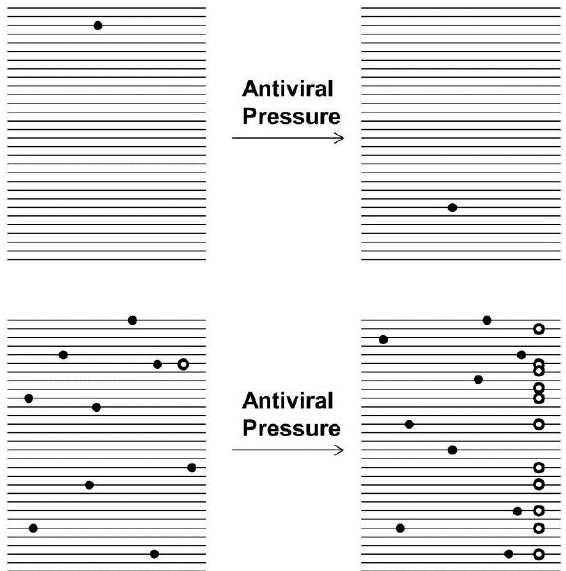
Figure 1. Virus quasispecies . A representation of mutation differences between DNA species (top panel) and an RNA virus quasispecies (bottom panel). Each line represents a portion of the genome, and each circle is a randomly-generated mutation. Each mutation will have a random effect, with most mutations being deleterious or neutral (dark circles), but with a small chance to disrupt targeted interactions by drugs, antibodies, or RNAi (white cirlces). In the DNA population on top, there is very little genetic variation, and thus it would be expected to have a nearly uniform phenotype in most environments. The RNA quasispecies on bottom however contains many unique random mutations, each of which will have an unknown effect. If the mutations happen to be in a gene targeted by a specific antibody or drug, then that virus could be resistant, and would be favored to multiply and increase its proportion in the quasispecies, creating a larger pool of resistant viruses.